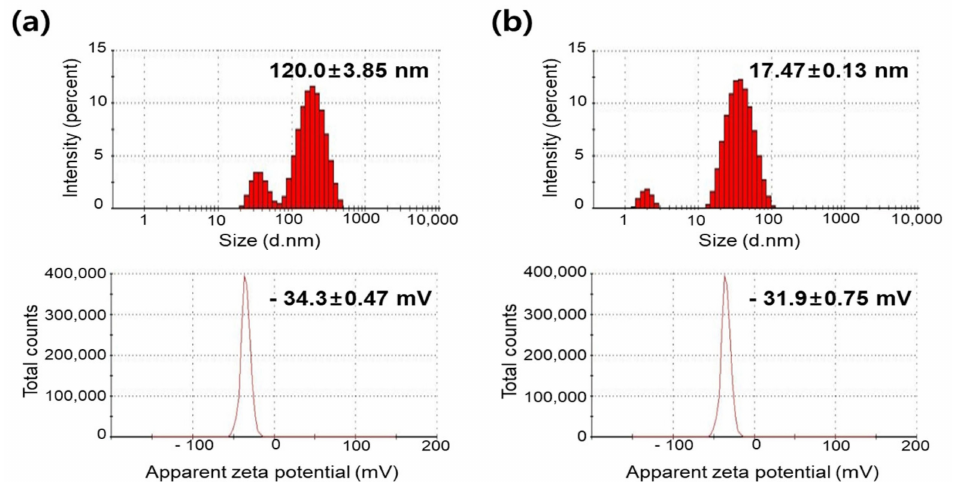
Figure 2. Dynamic light scattering (DLS) showing the colloidal size and Zeta potential of ( a ) SS-AgNPs and ( b )